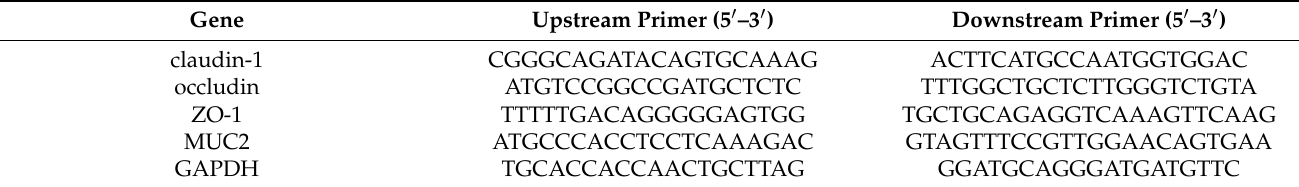
Table 3. Primer Sequence used in